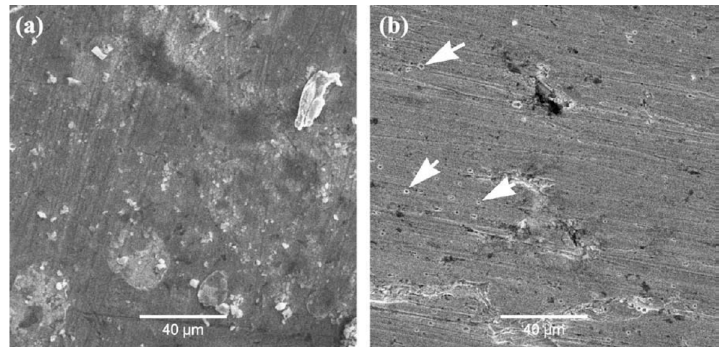
Figure 11. SEM micrographs for ( a ) Fe-Mn-Al-Si, and ( b ) interstitial-free (IF) steel after polarization experiments in 3.5 wt.% NaCl [108]. (Reproduced with permission from refs. [108]. Copyright (2008), Elsevier).